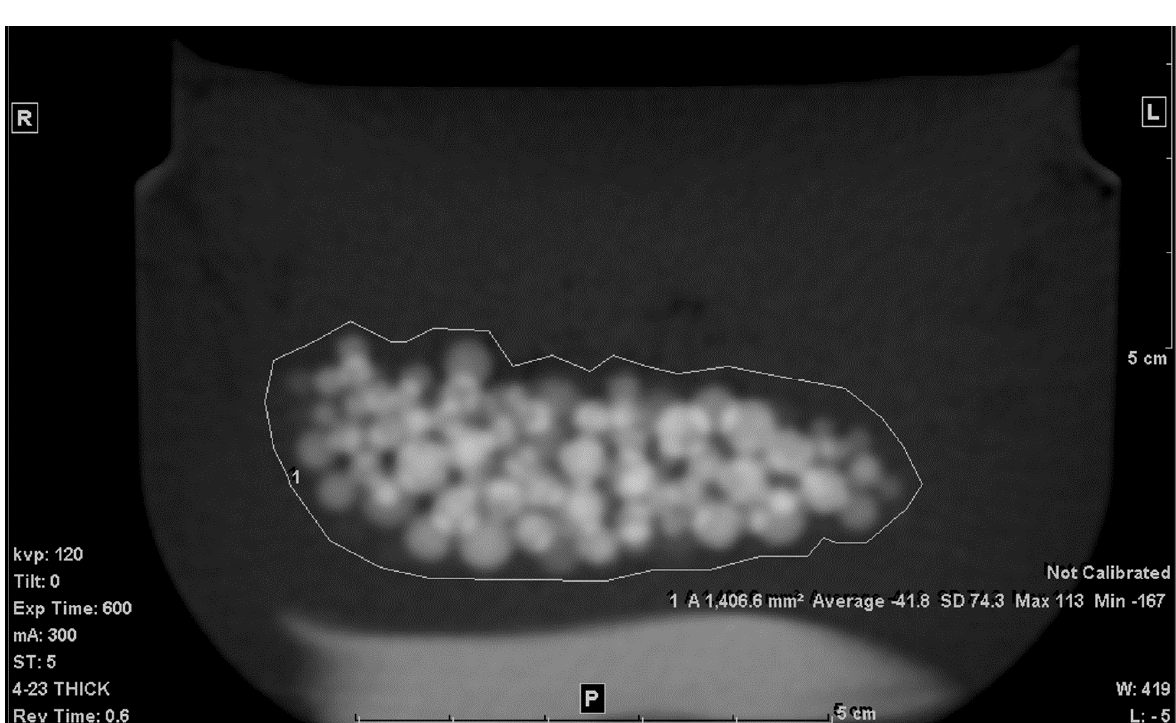
Figure 2. Freehand ROI of the mixture on a 5 mm-thick slice.